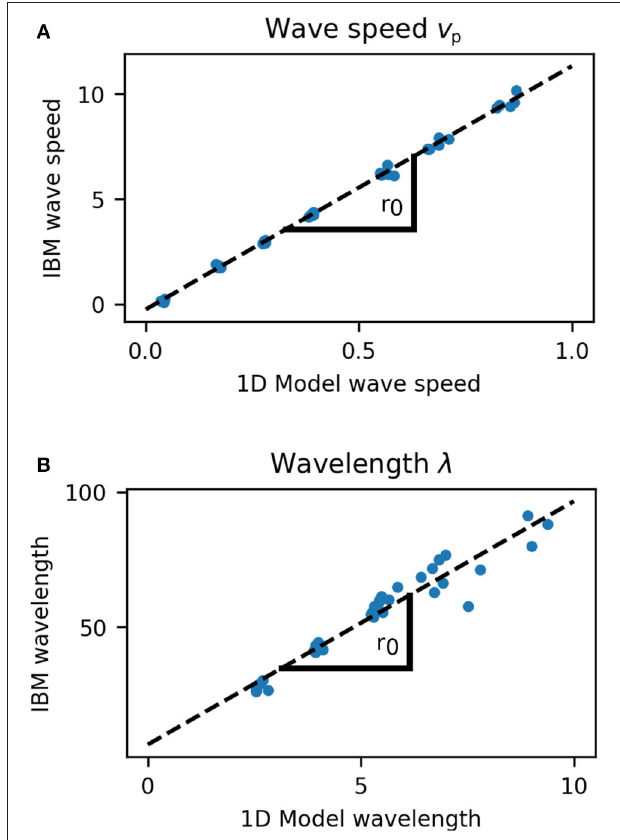
FIGURE 8 | Comparison of wave speed (A) and wavelength (B) between 1D model and growing cell colonies (IBM). The length scale of wave speed and wavelength is set by r 0 and the slope of these plots gives estimates for r 0 as 11.6 (wave speed) and 9.01 (wavelength) cell diameters. Speed and wavelength of traveling waves were closely correlated between the models, with Pearson’s correlation coefficient 0.999 for wave speed, and 0.983 for